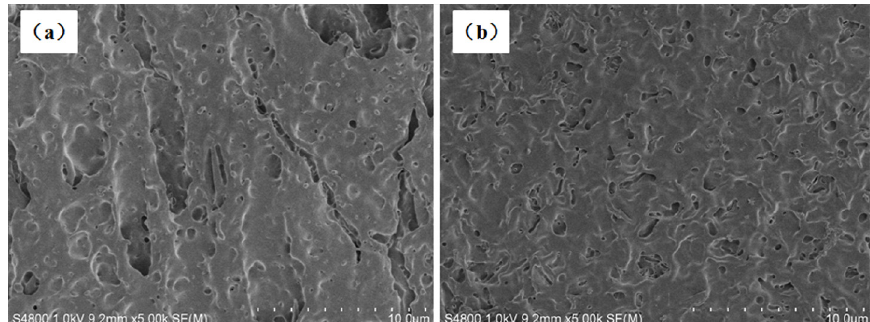
Figure 5. SEM images of the sample surfaces after eight-week hydrolytic degradation showing the erosion phenomena: ( a ) PLA and ( b ) PLA/PBAT (80/20, w / w